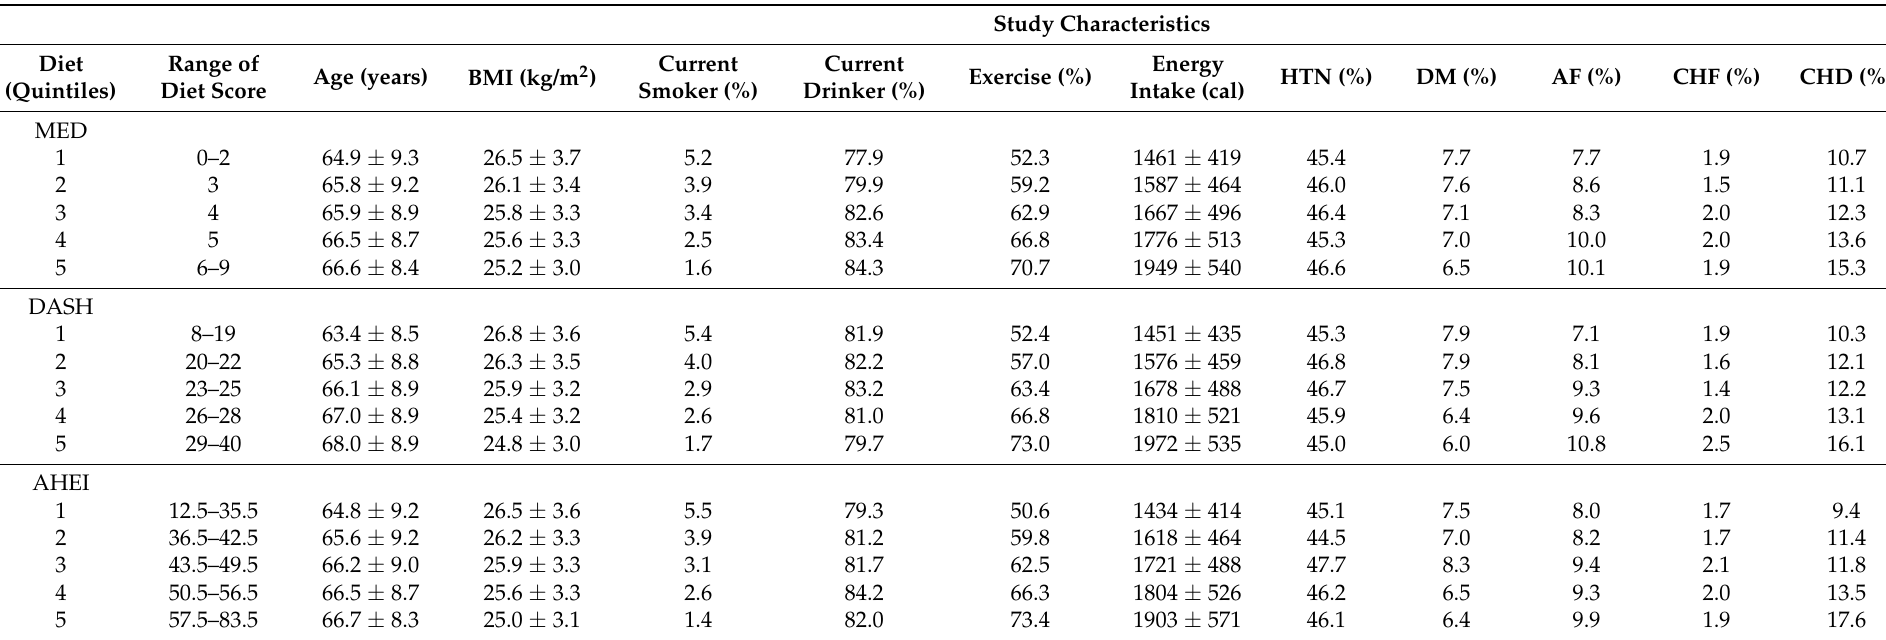
Table 1. Characteristics of the 15,768 study participants in the Physicians’ Health Study according to quintiles of the MED, DASH, and AHEI scores. Study